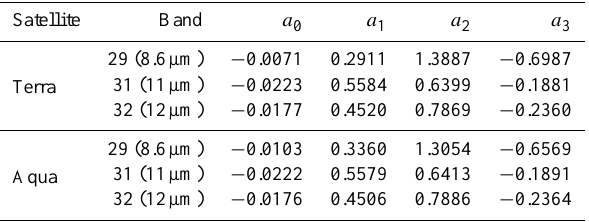
Table 1. Cubic polynomial relationship coefficients (see Eq. 9) computed for the MODIS-Terra and MODIS-Aqua channels 29, 31, and 32.